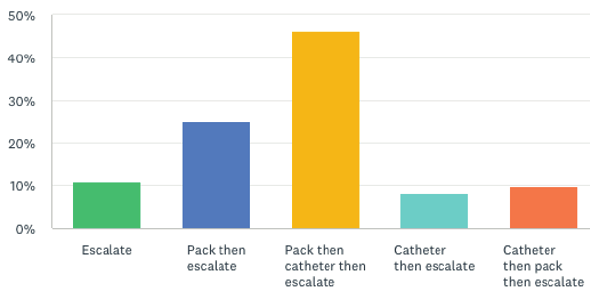
Figure 10. ‘What is your treatment hierarchy for the management of pos- terior